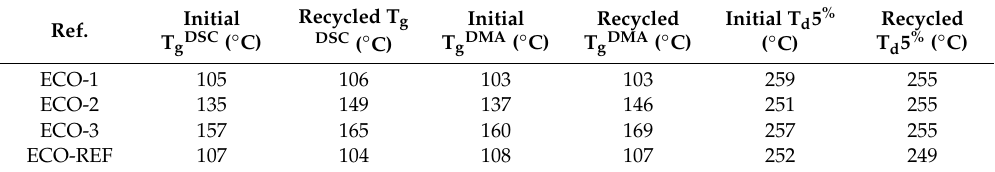
Table 5. Thermal properties of the prepared vitrimers (pristine and